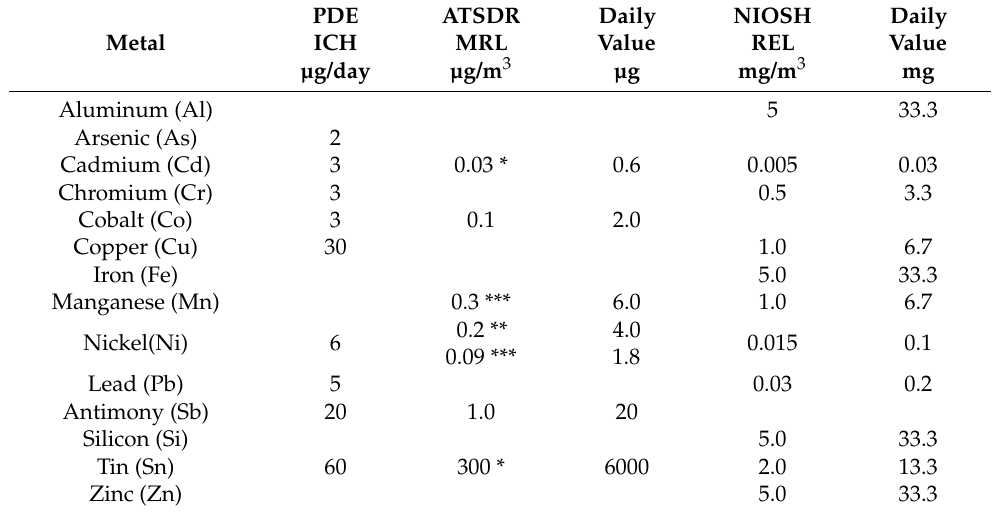
Table 2. Toxicological References. The table displays the minimal recommended values to avoid noticeable harm. The daily values for the MRL-ATSDR and REL-NIOSH are, respectively, computed for 24 and 8 h. The asterisks denote short term exposures (* daily, ** 15 days) and chronic exposure *** (more than 360